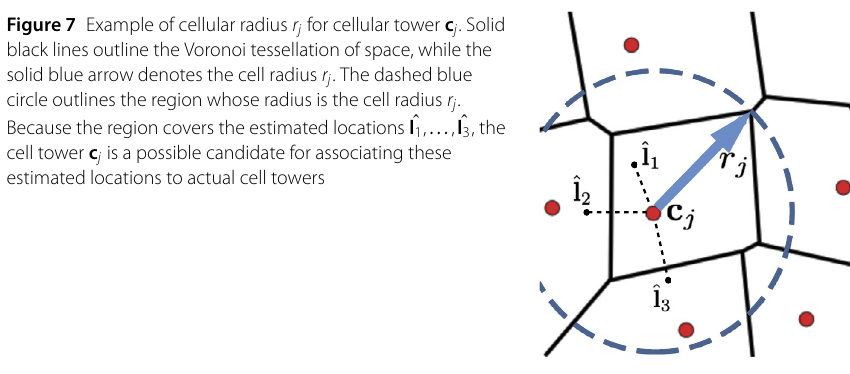
Figure 7 Example of cellular radius r j for cellular tower c j . Solid black lines outline the Voronoi tessellation of space, while the solid blue arrow denotes the cell radius r j . The dashed blue circle outlines the region whose radius is the cell radius r j . Because the region covers the estimated locations ˆ l 1 , ... , ˆ l 3 ,